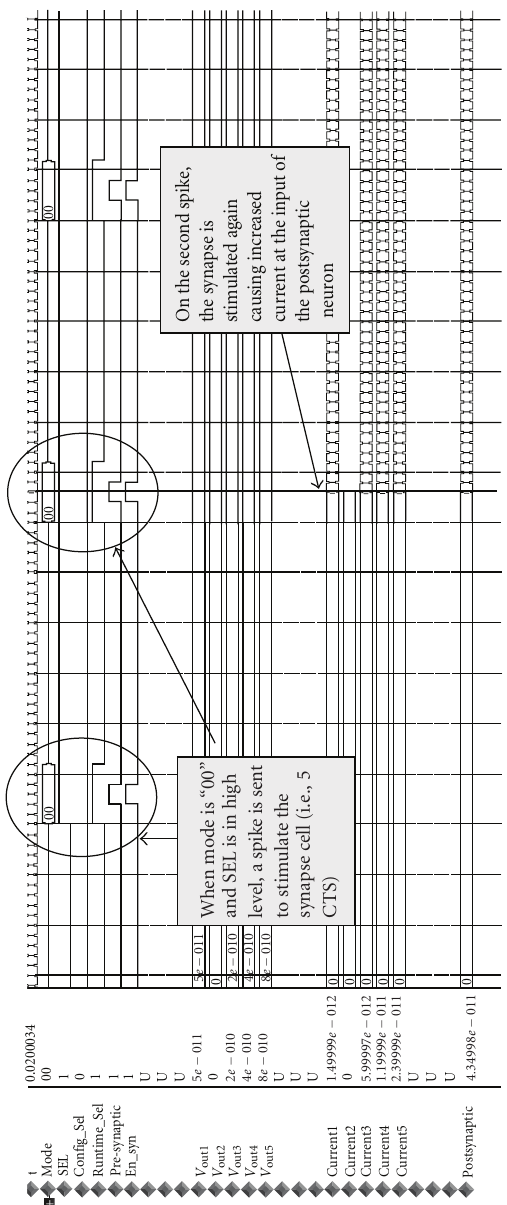
Figure 9: Runtime mode of the tile showing two packets being received. A spike train consisting of two spikes is directed to the 5 CTS. The total postsynaptic current of the individual CTS currents (current 1, 3, 4, and 5) increases in value with each spike